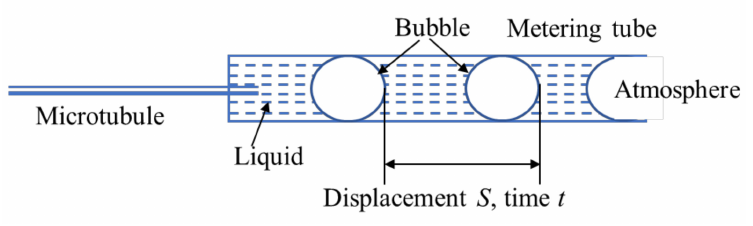
Figure 3. Schematic diagram of flow measurement by displacement method in the metering